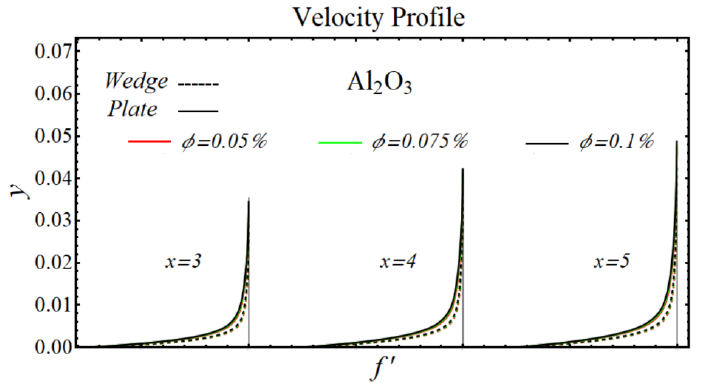
Figure 21. Velocity profile of Al 2 O 3 /DIW nanofluids over the wedge and plate under the impact of nanoparticle volume fraction.